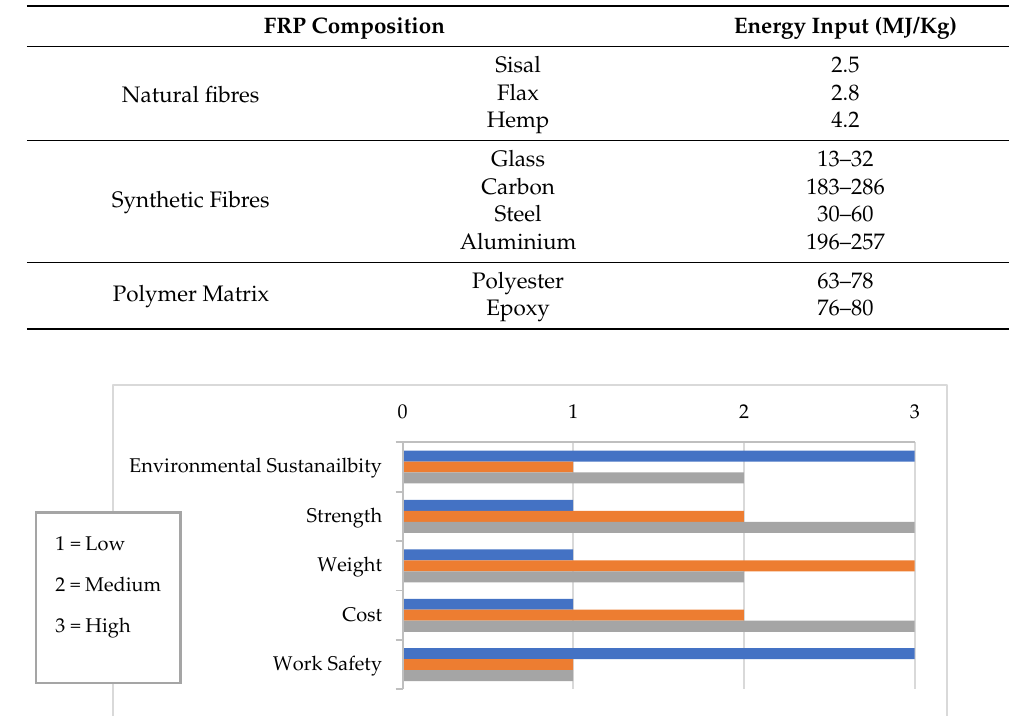
Figure 5. Cost comparison between natural and synthetic fibres. Table 1. Energy input of FRP composition [33,35]. Table 1. Energy input of FRP composition [33,35].